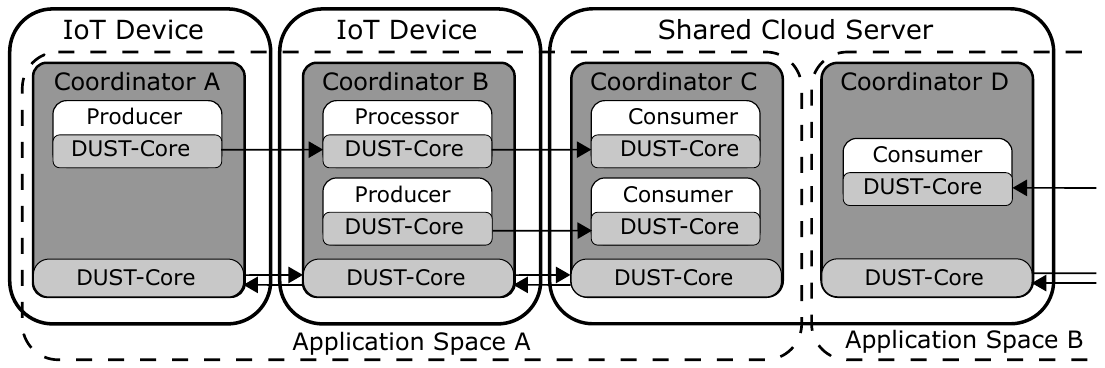
Figure 3. The DUST system architecture using the DUST Core and the DUST Coordinators with multiple application